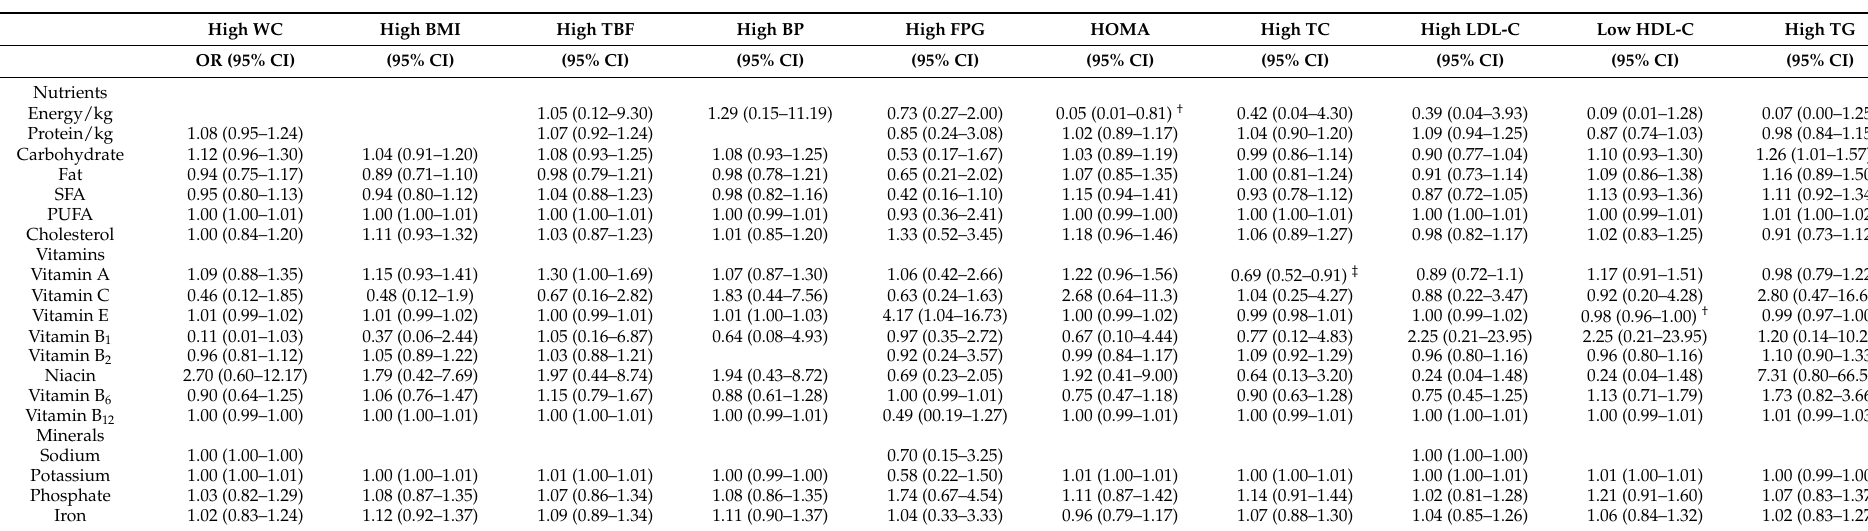
Table 3. Odds ratios of having traditional cardiovascular disease risk factors among renal transplant recipients with adequate nutrient